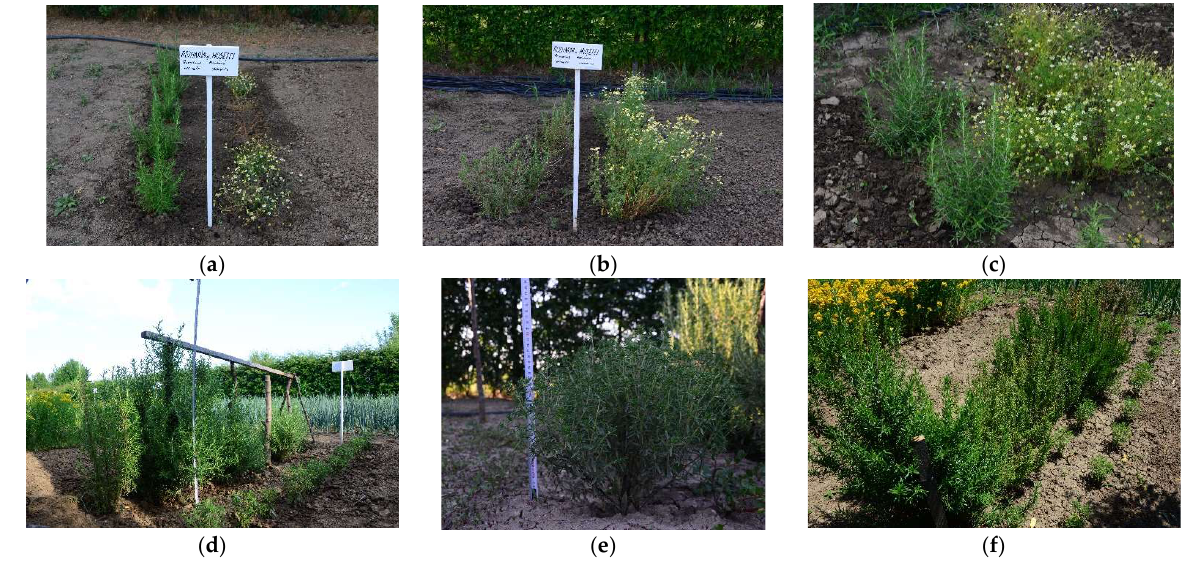
Figure 6. The horizontal evolution of Rosmarinus officinalis L. and Matricaria chamomilla L. phy- tosociological crops during 2018–2019, changed with Rosmarinus officinalis L. and Thymus vulgaris L. during 2020–2021 ( a – f ), where h—height. ( a ) Phytosociological crop rosemary (h-44 cm) and chamomile (h-24 cm), May 2018; ( b ) Phytoso-ciological crop rosemary (h-49 cm) and chamomile (h-54 cm), May 2019; ( c ) Phytosociological crop rosemary (h-53 cm) and chamomile (h-62 cm), June 2019; ( d ) Phytosociological crop rosemary (h-98 cm) and thyme (h-18 cm), May 2020; ( e ) Phytosocio- logical crop rosemary (h-120 cm) and thyme (h-30 cm), June 2020; ( f ) Phytosociological crop rosemary (h-130 cm) and thyme (h-24 cm), June 2021.